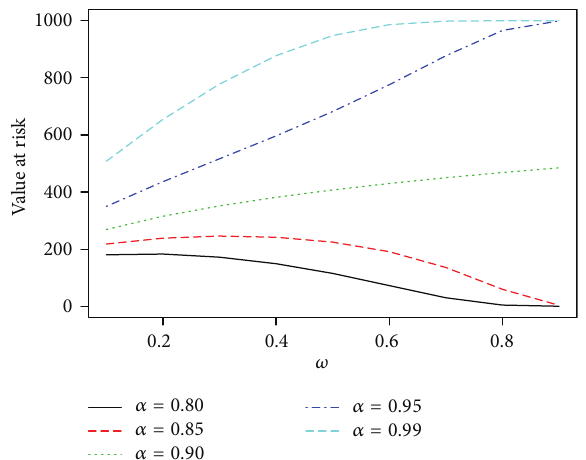
Figure 5: The approximated VaRs of 𝑆 1000 , by confidence level 𝛼 and the limiting correlation 𝜔 , under the 𝛽 - 𝛽 model.